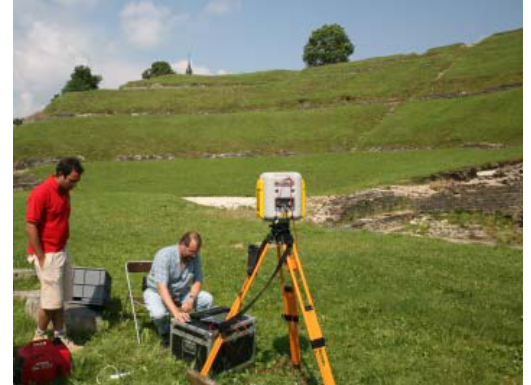
Figure 7. Positioning of the Trimble GX TLS at the ground level of the theatre of Mandeure.